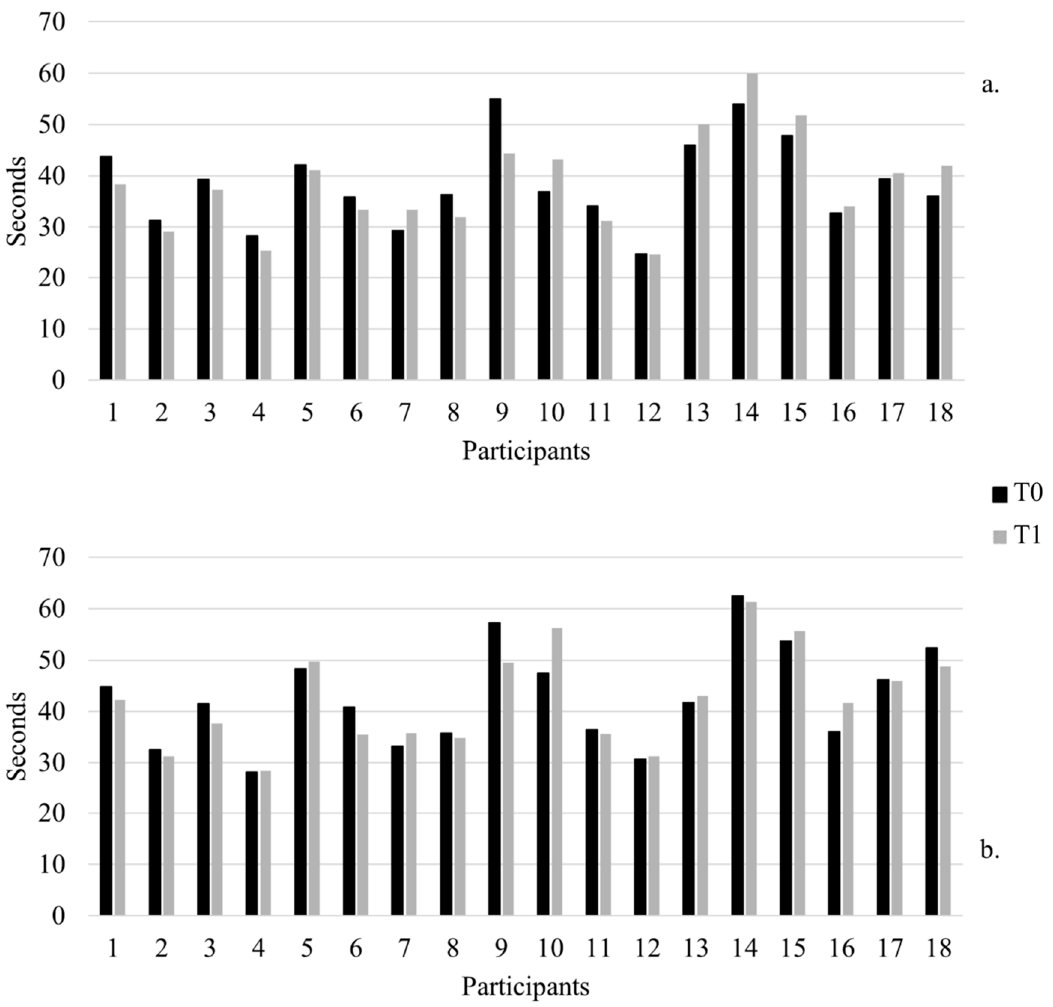
Figure 3. ( a ) Dominant and ( b ) non-dominant hands individual 9HPT scores for each participant at T0 and T1. Participants in the IG are numbered from one to nine; those in the CG are numbered from 10 to 18. Lower values represent better performance.